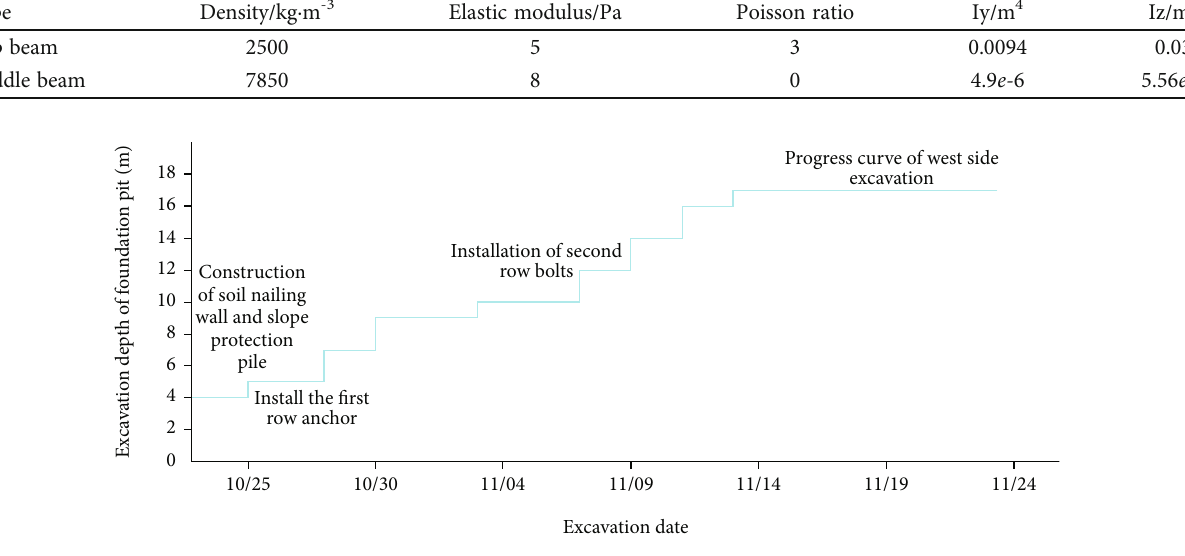
Figure 4: Progress curve of excavation on the west side of foundation pit.